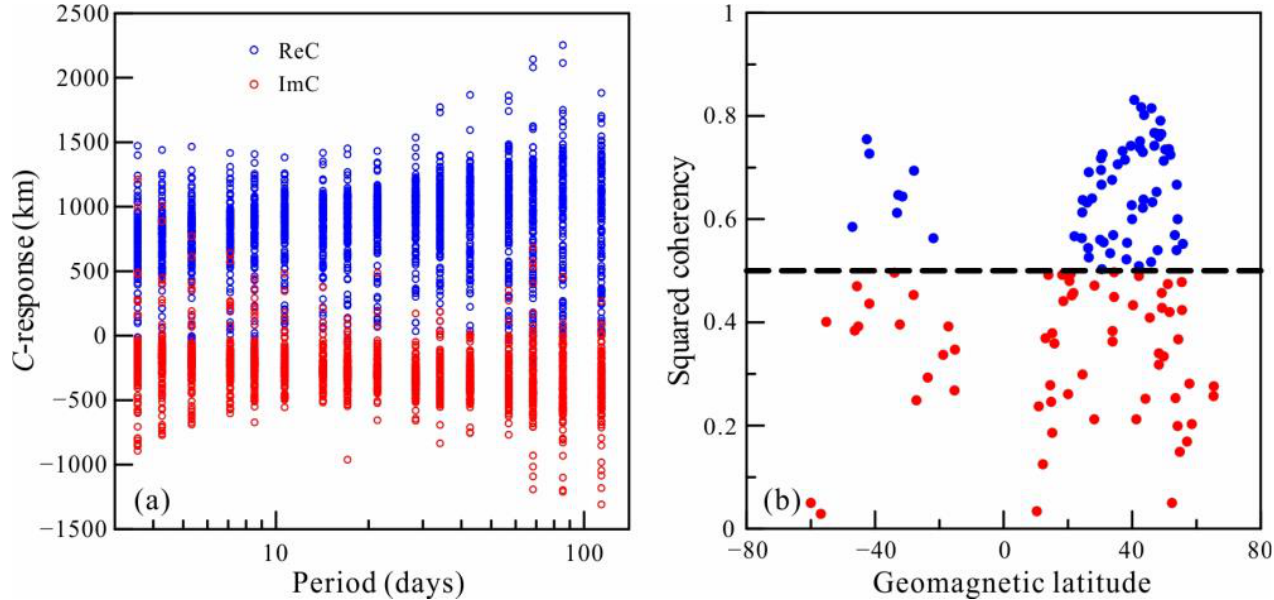
Figure 10. C -responses ( a ) and squared coherencies ( b ) over all periods at 129 selected observatories. In ( b ), blue circles (squared coherency ≥ 0.5) represent C -responses with good quality, and red circles (squared coherency < 0.5) represent C -responses with poor quality.